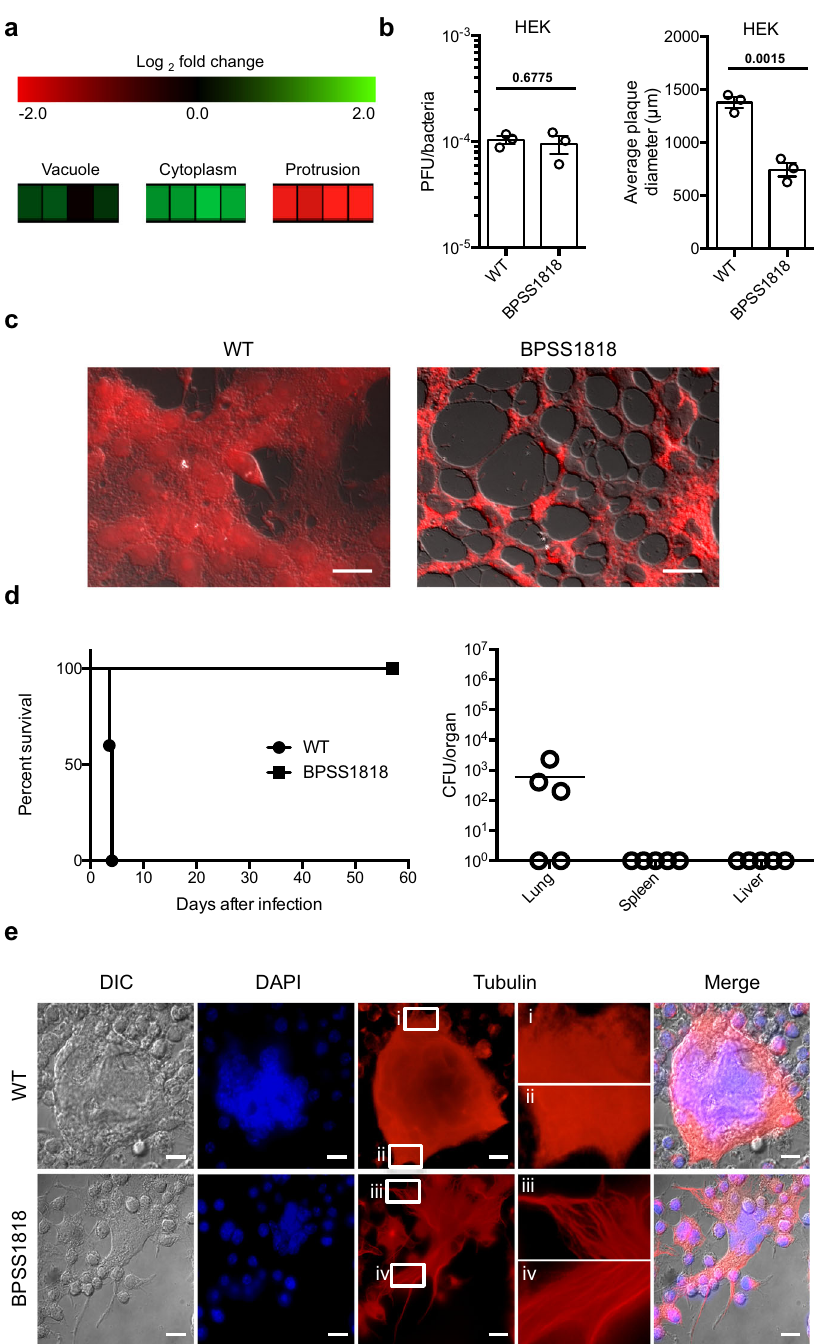
Fig. 3 Characterizations of Bp mutant BPSS1818. a BPSS1818 gene is upregulated within the macrophage cytosol, then signi fi cantly downregulated during the protrusion stage of infection. First three boxes of each infection stage represent three biological replicates, the fourth represents the mean. b Number of plaques formed (PFU) by the BPSS1818 mutant is comparable to wild-type Bp , indicating no defect in host cell invasion; however, reduced plaque diameters were observed indicating defect in infection spread ( n = 3). Data represent means ± s.e.m. and analyzed via two-sided unpaired t -test. P values presented above relevant comparisons. c Fused RAW264.7 cells infected with the BPSS1818 mutant show extended host cell cytoskeleton and distended MNGCs compared to wild-type Bp . Scale bars = 5 μ m. d The BPSS1818 mutant is completely attenuated in BALB/c mice ( n = 5) when compared to wild-type Bp . Bacterial burdens were only observed at low levels in lungs of three mice. e RAW264.7 cells infected with the BPSS1818 mutant showed elongated microtubules with pronounced fi bers when magni fi ed in contrast to wild-type Bp infected cells. Scale bars = 10 μ this gene showed a signi fi cant decrease in intracellular replication importance for later steps of the infection lifecycle (Fig. 4a). In and plaque sizes in RAW264.7 and HEK293T cells, respectively vitro growth and complementation analyses in Fig. S5b show that (Supplementary Fig. 4d, Fig. 4b). When used to infect BALB/c these defects are not caused by reduced in vitro fi tness, secondary mice at a lethal dose, all mice survived during the entire study mutation, or polar effect, suggesting that mutation in BPSS0015 is period, indicating that the BPSS0015 gene is an essential virulence responsible for the observed phenotypes in Fig. 4. A mutant of